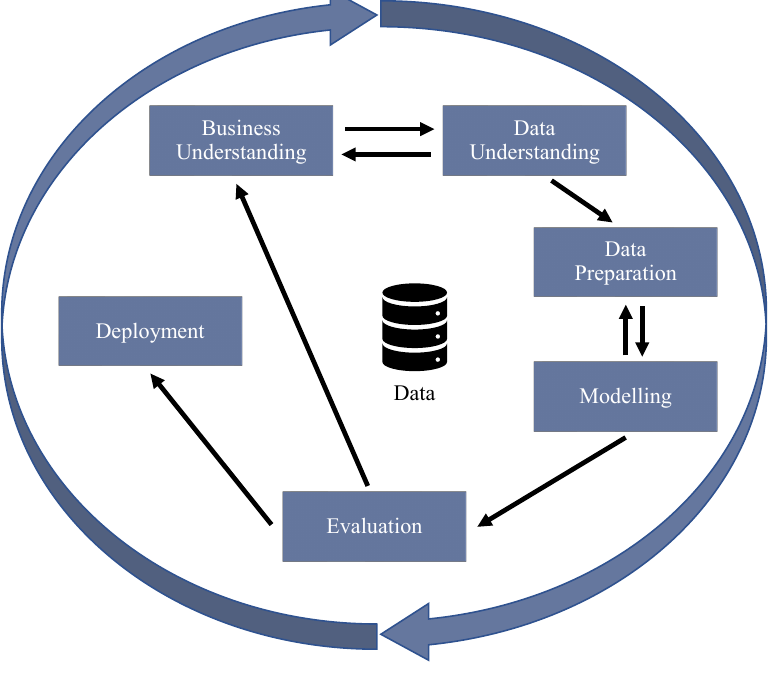
Figure 3. CRISP-DM process following